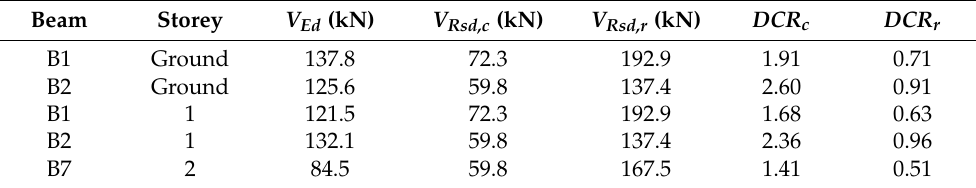
Table 4. Shear demand, capacity values in current and retrofitted conditions, and relevant de- mand/capacity DCR ratios–selected